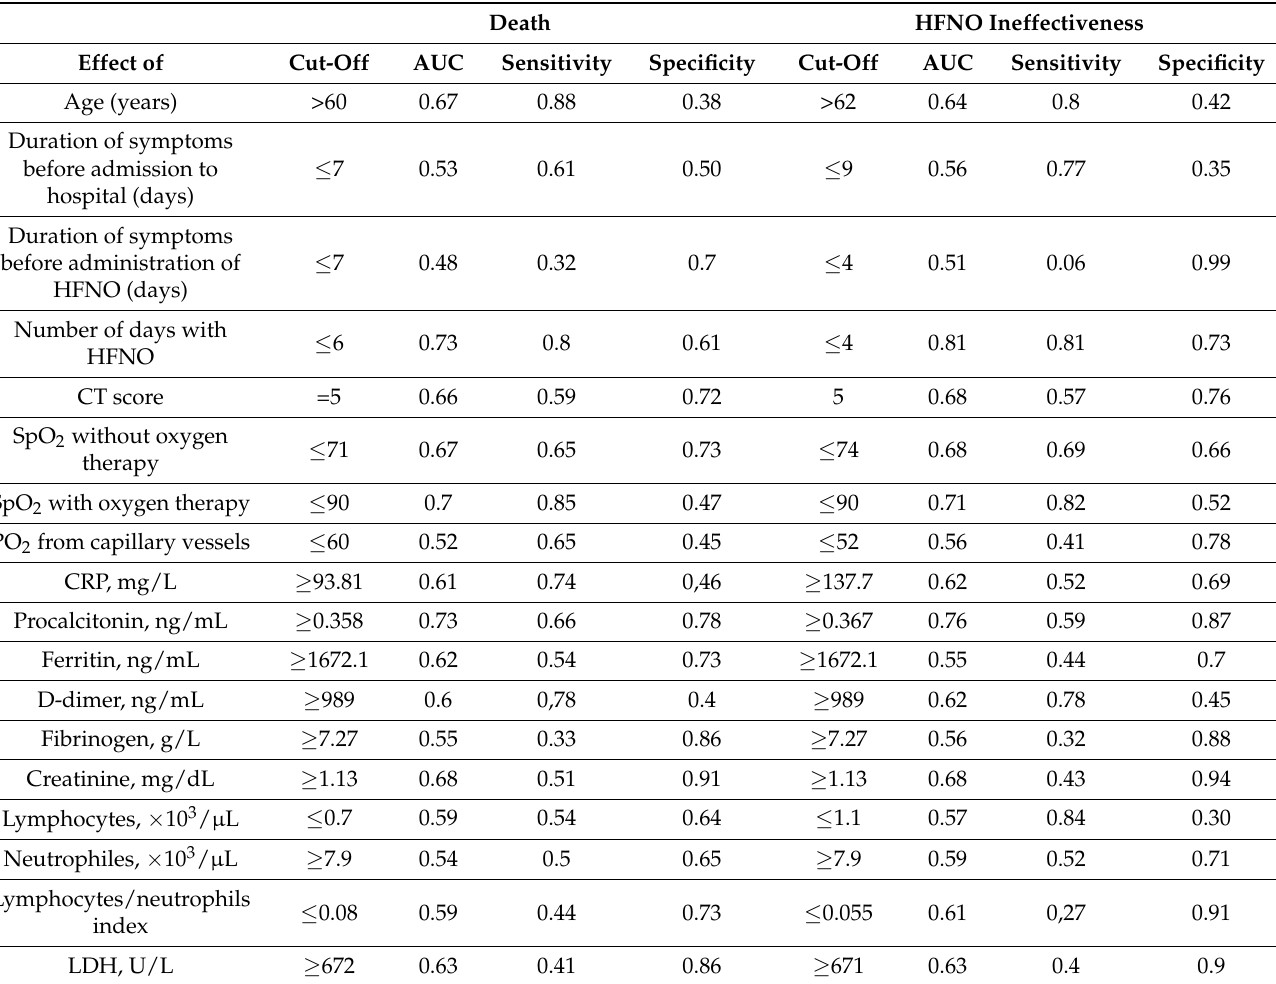
Table 3. Area under the ROC curve (AUC), sensitivity and specificity for calculated cut